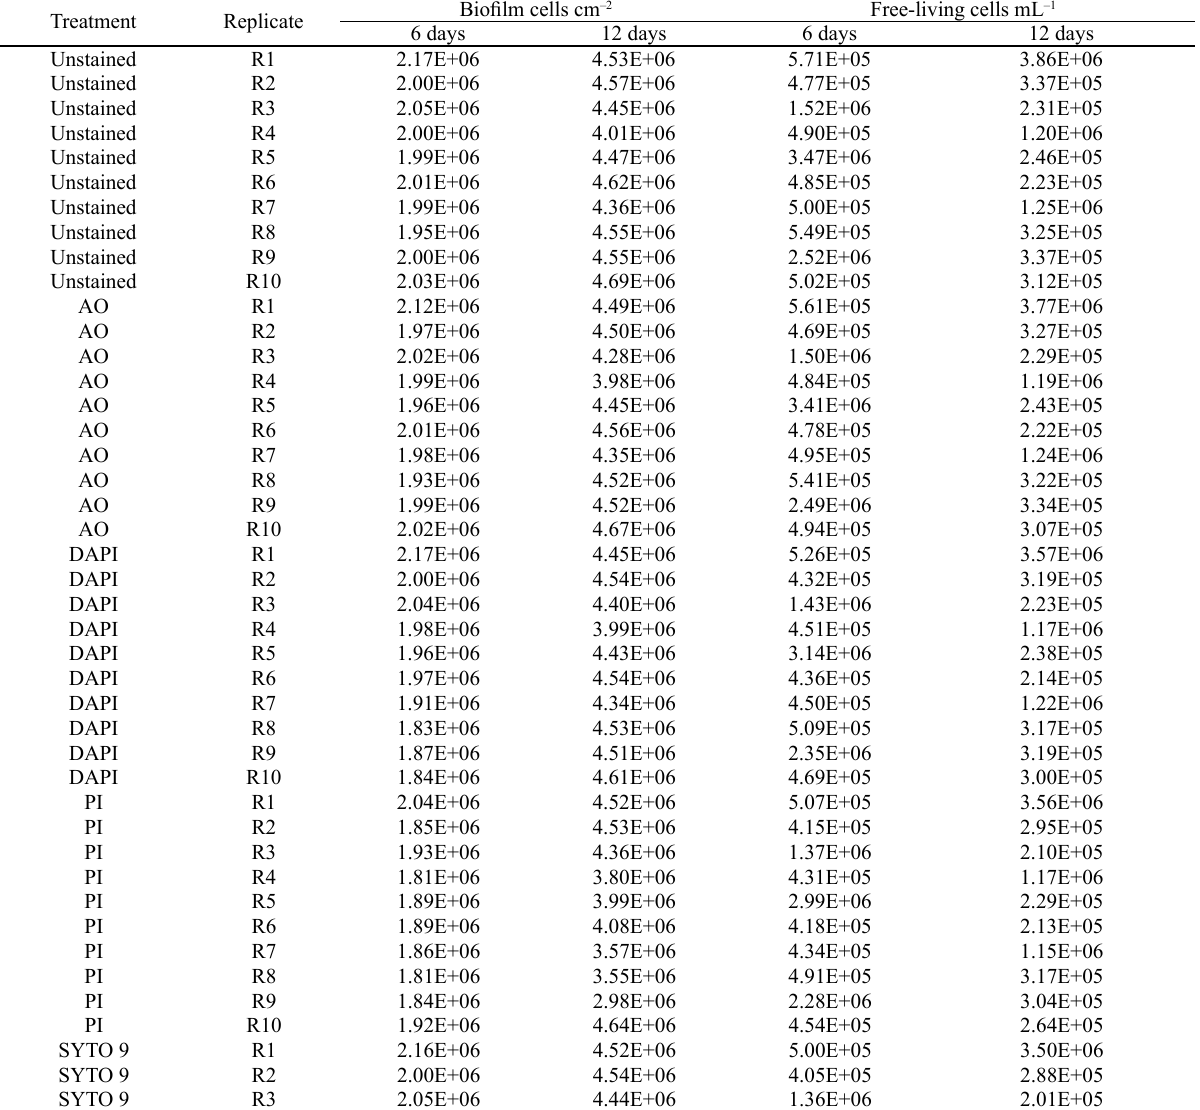
Table S3. – Free-living (ind mL –1 ) and biofilm (ind cm –2 ) prokaryote densities estimated by flow cytometer (unstained, AO, DAPI, PI and SYTO9) at 6 and 12 days of